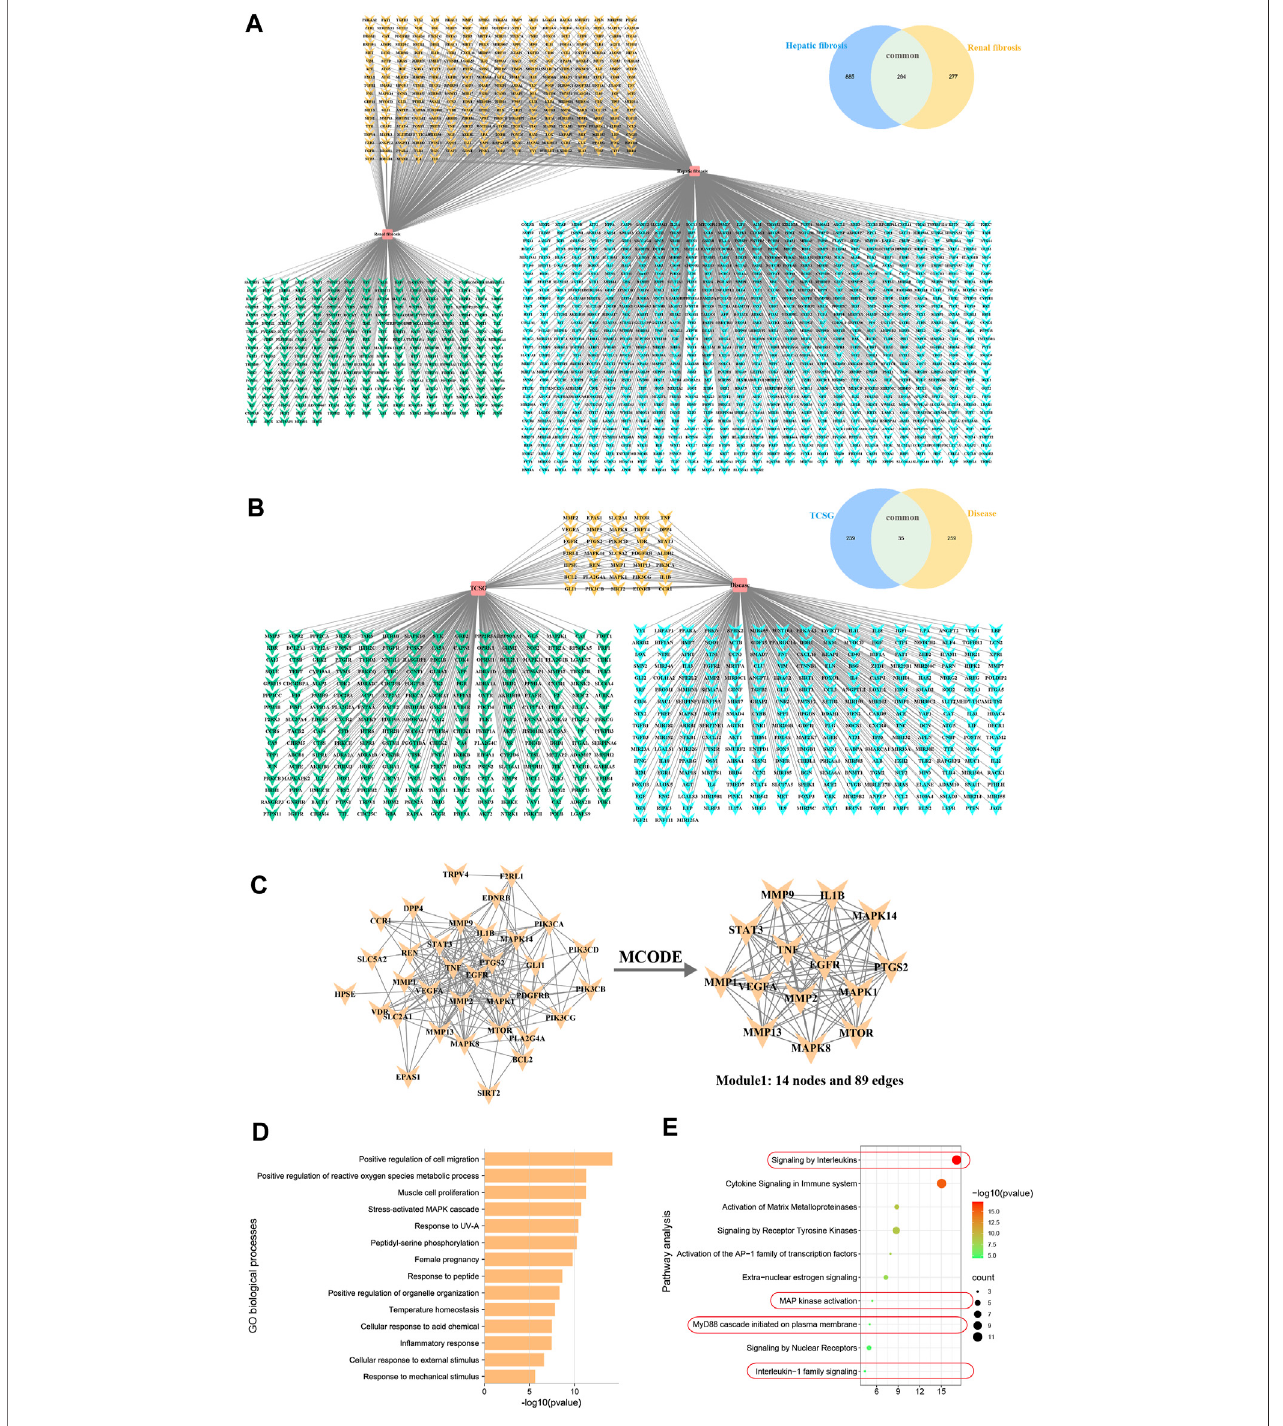
FIGURE 4 | Network pharmacology analyzed potential mechanisms for anti fi brotic effects of TCSG from Baishouwu . (A) Unique and shared disease targets for hepatic fi brosis and renal fi brosis. (B) Common targets of TCSG in treating hepatic and renal fi brosis. (C) Construction of PPI network for TCSG therapeutic targets and the core genes analyzed by plug-in MCODE. (D) GO enrichment analysis of core targets for TCSG in treating hepatic and renal fi brosis. (E) Reactome pathways enrichment analysis of core targets for TCSG in treating hepatic and renal fi brosis.